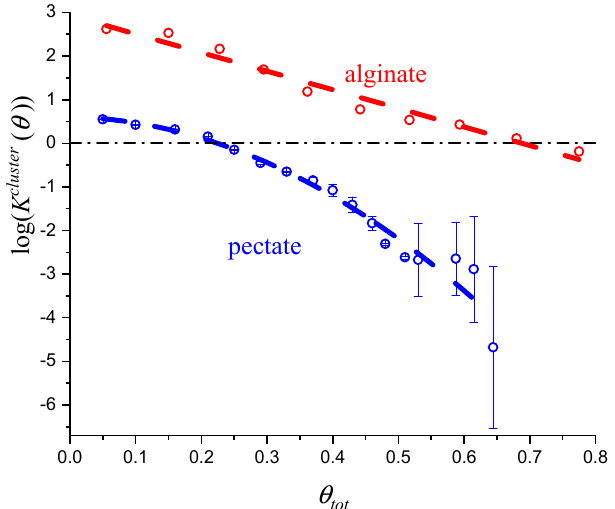
Figure 6. Dependence on the total fraction of chemically bound calcium ions, θ tot , of the logarithm of the clusterization constant, K cluster ( θ ) , as defined by Equation (16). Red symbols, alginate; blue symbols, pectate.